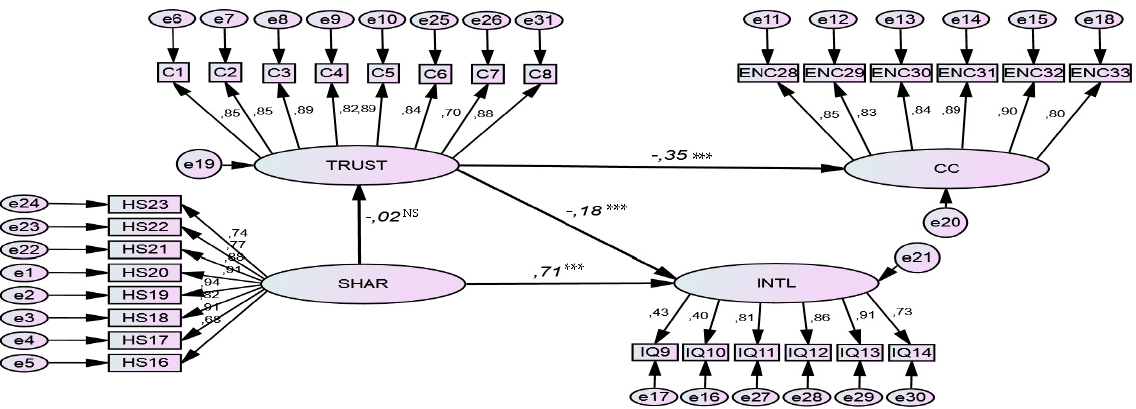
* Diagonal values: the square root of AVE for each dimension; below diagonal values: intercorrela- tion between dimensions.